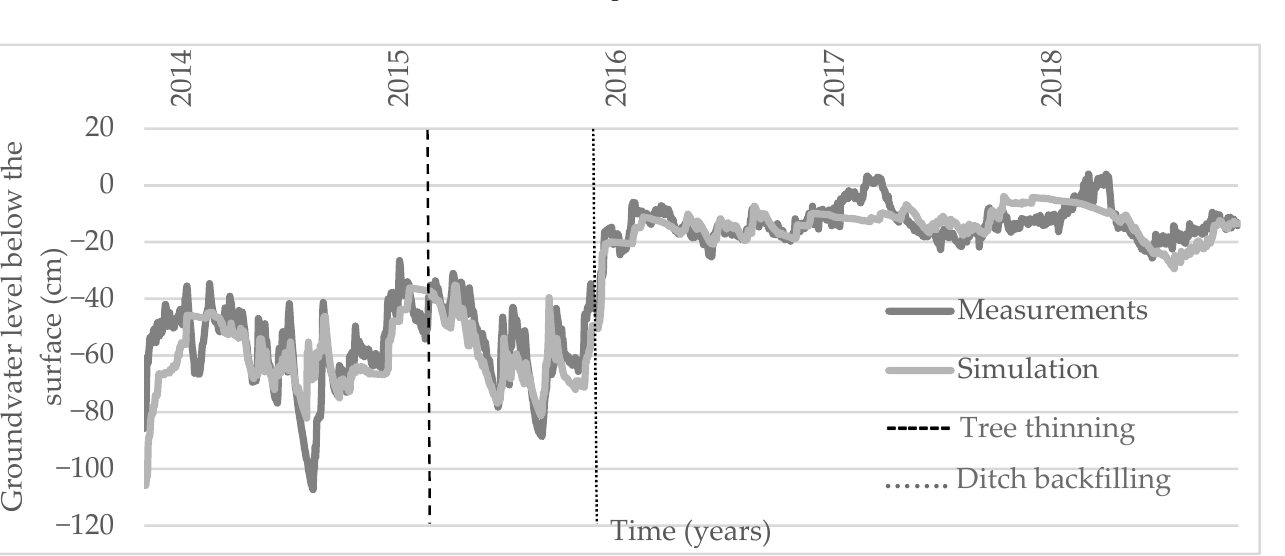
Figure 8. Groundwater level estimates for plot 4 after adjusting the precipitation parameter to include the water supply from surface runoff. The plot 5 received a distinct combined treatment of ditch backfilling with peat soil and 34% tree removal (the vertical lines in Figure 9). It was lower-lying than the other plots (30 m above sea level) and all the drainage ditches separating it from the raised bog in the west were closed during the experiment (Figure 3). Being located approximately one meter below the plot 4, the drainage impact on its water balance was even more pronounced here. In order to fit the simulated groundwater level curve with the observations, the precipitation parameter should be increased 6.2 times for the period before the ditch closure, but only 1.7 times after the backfilling. This difference probably reflects the share of the surface runoff from higher areas.